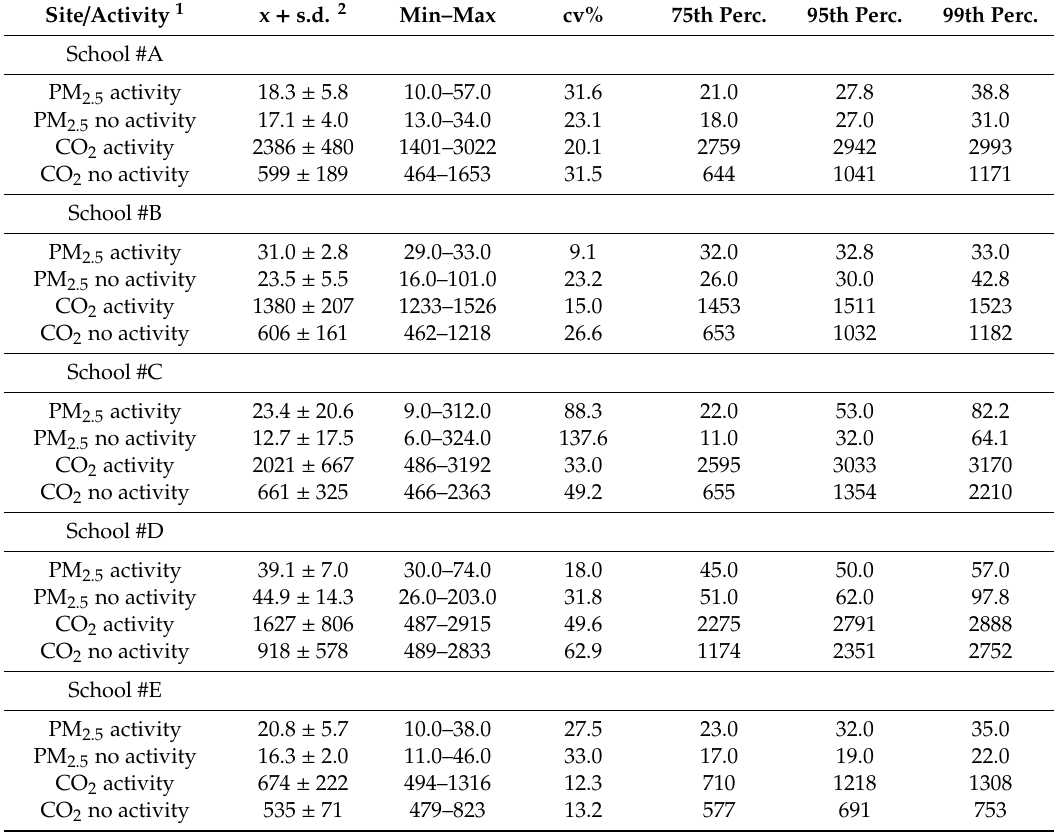
Table 2. Daily levels of indoor PM 2.5 ( µ g m − 3 ) and CO 2 (ppm), respectively, in eight schools in downtown